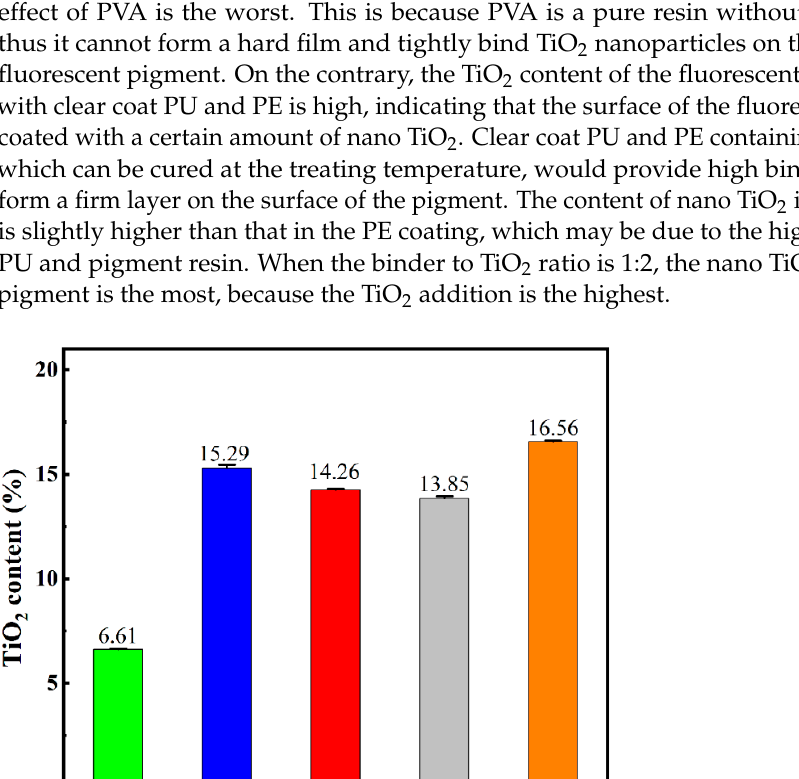
Table 3. Ash test results of raw materials and binders. Samples